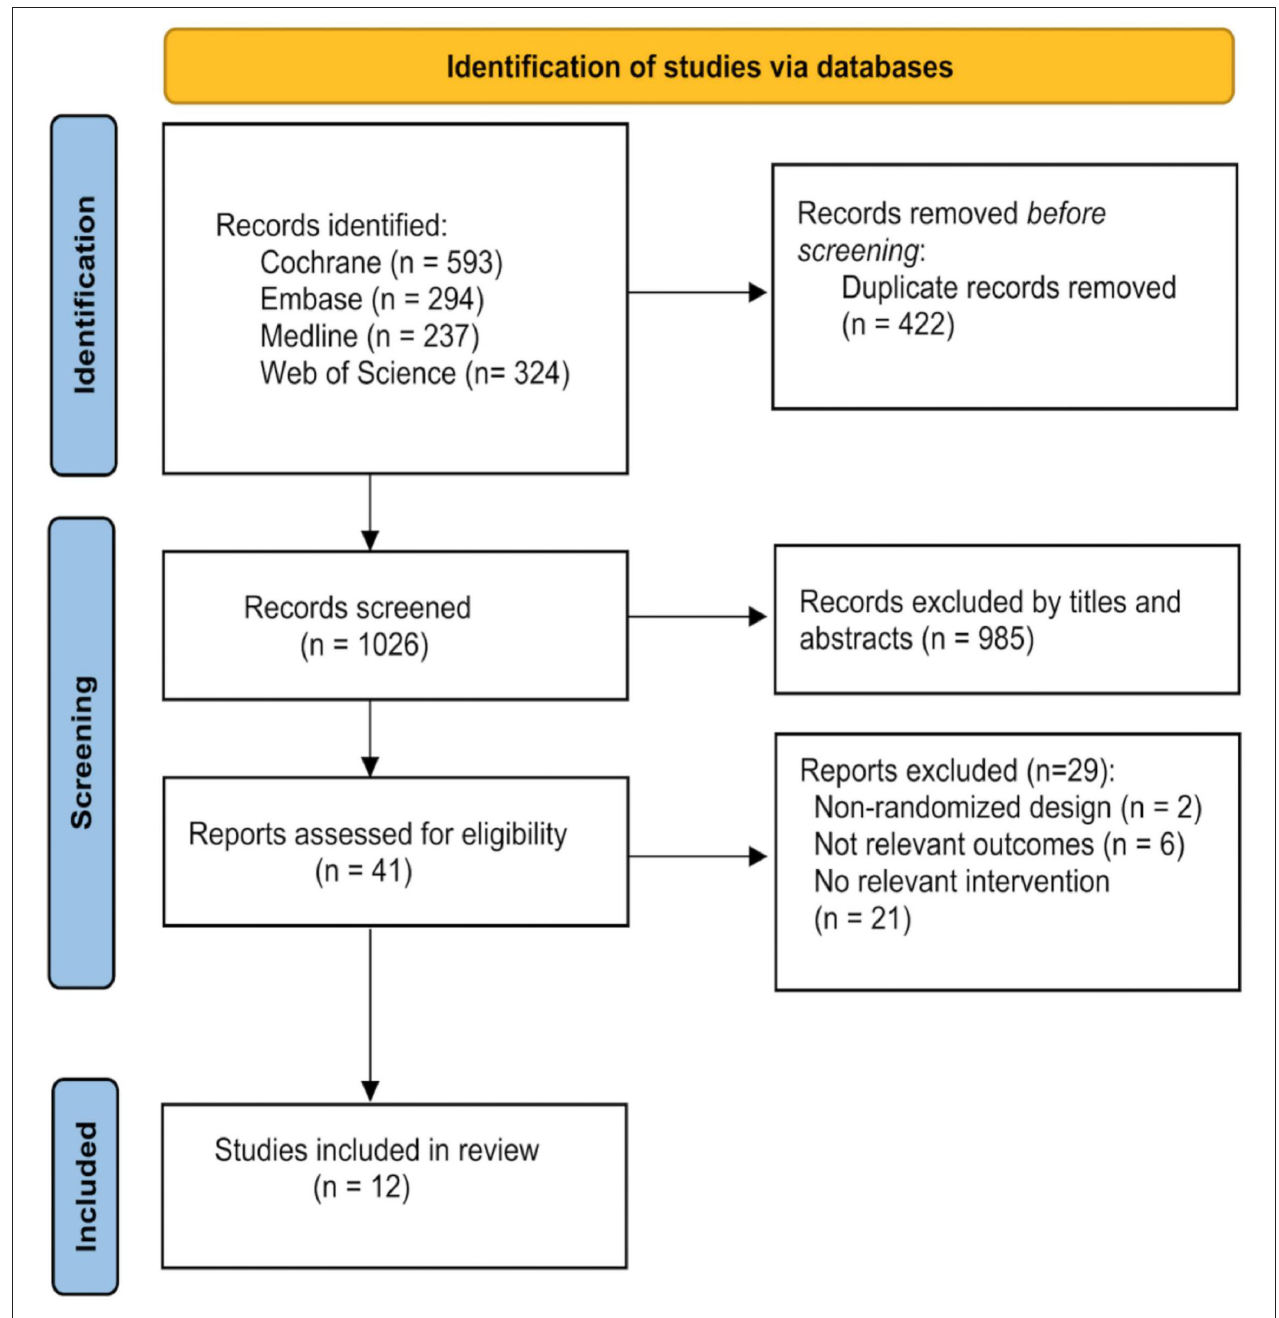
FIGURE 1 | Summary of trial identification and